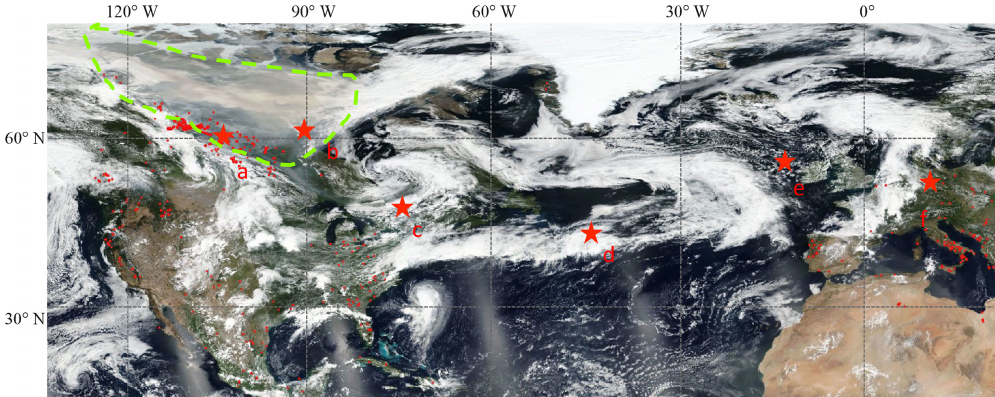
Figure 4. The corrected surface reflectance overlaid with fire and thermal anomalies from MODIS (15 August 2017). The region marked with the dashed green line in the northwest indicated a plume generated by fire activities. Six locations (labeled as red stars) on the tracks of CALIPSO are selected: (a) (61.47 ◦ N, 106.44 ◦ W), (b) (62.79 ◦ N, 91.54 ◦ W), (c) (46.97 ◦ N, 72.22 ◦ W), (d) (42.27 ◦ N, 42.08 ◦ W), (e) (55.97 ◦ N, 12.54 ◦ W), and (f) (52.37 ◦ N, 13.47 ◦ E). The corresponding overpass date is 14, 15, 17, 19, 21, and 23 August